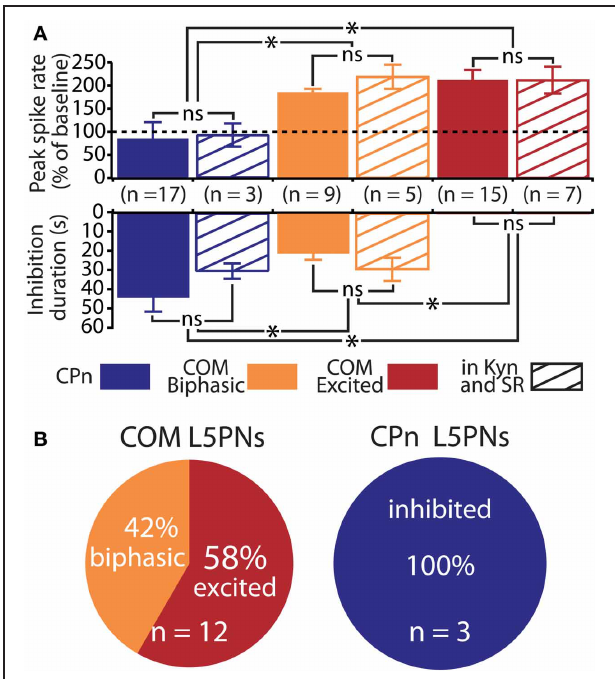
FIGURE 5 | Serotonergic regulation of commissural/callosal (COM) and corticopontine (CPn) projection neurons does not require changes in fast synaptic transmission. (A) Comparisons of the duration of inhibition (bottom) and serotonin-induced changes in spike rate (top) in COM and CPn neurons in regular saline (solid bars) and in the presence of synaptic blockers (4mM kynurenic acid, 10 µ M SR 95531; striped bars). NS indicates non-significant differences between within-cell-type groups (unpaired Student’s t -tests). Asterisks indicate p < 0 . 05 (One-Way ANOVAs). (B) Proportions of serotonergic responses in COM (top) and CPn neurons (bottom) recorded in the presence of 4mM kynurenic acid and 10 µ M